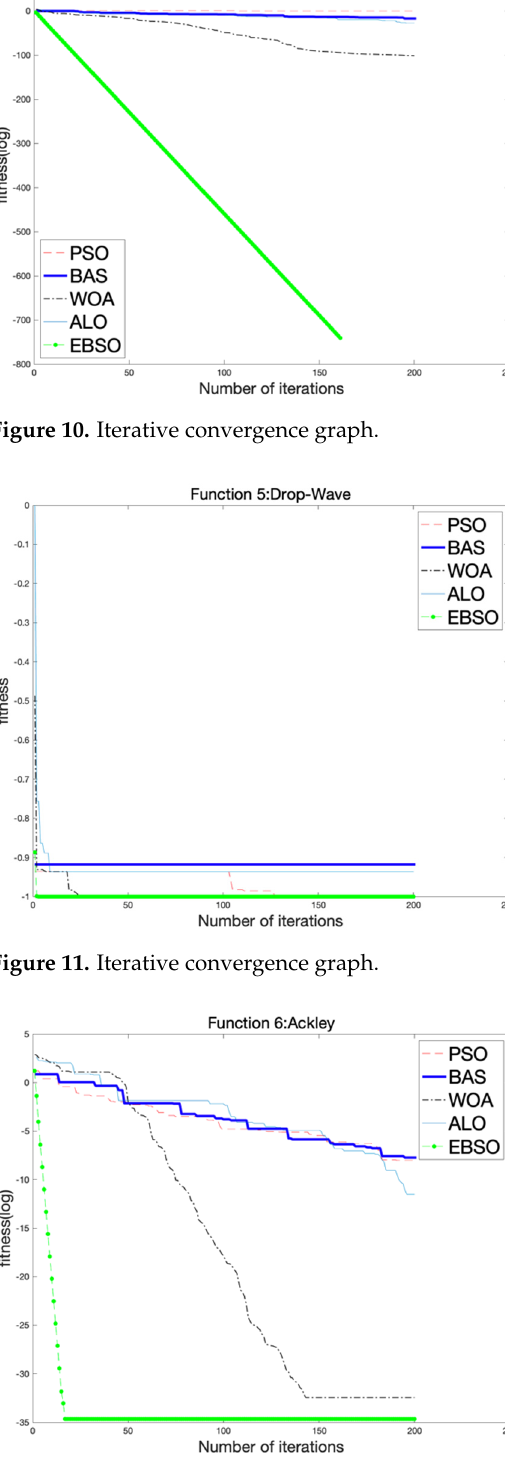
Figure 12. Iterative convergence graph.